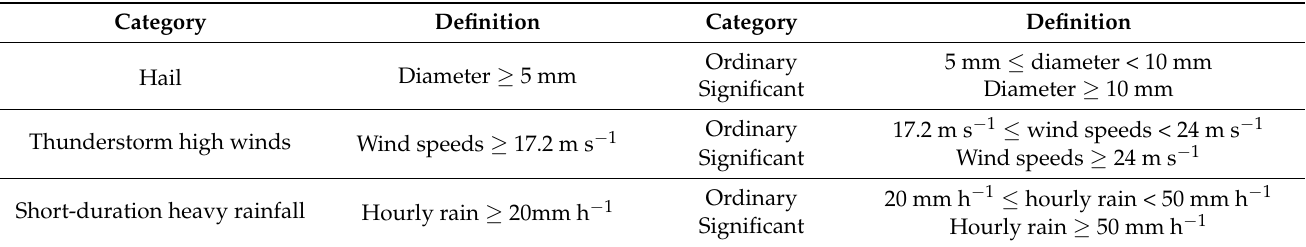
Table 1. Definition and classification (according to severity) of three types of severe convective events. Category